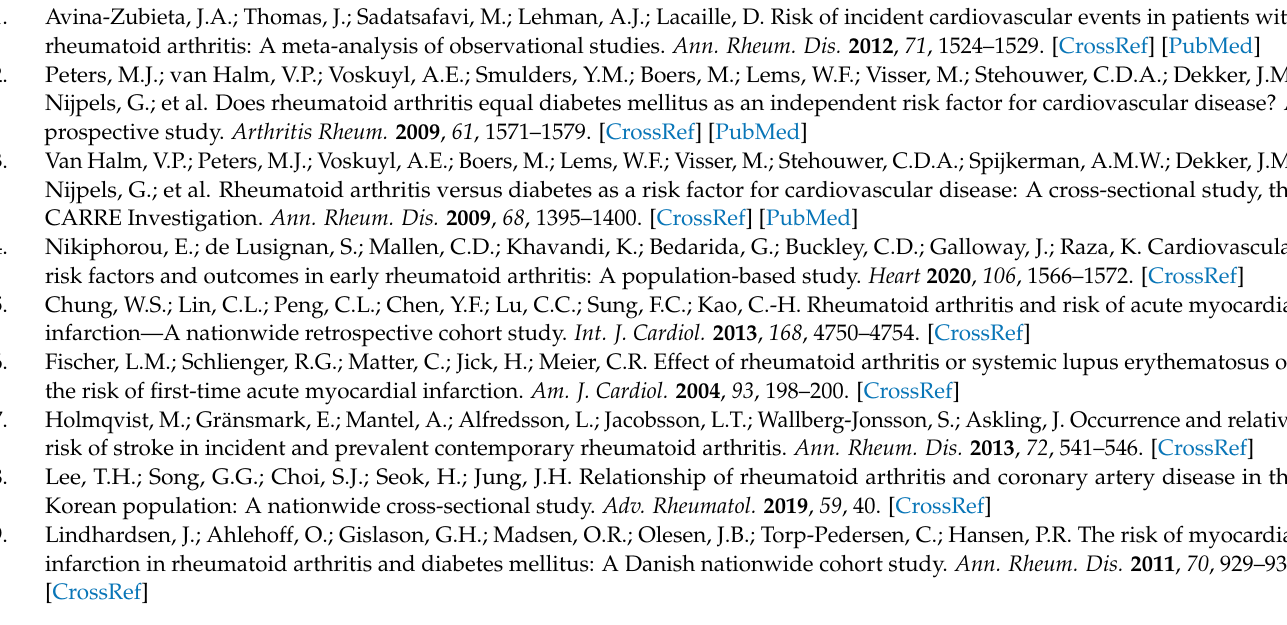
Table S2. Stratified analysis–Stroke; Table S3. Baseline characteristics of the study population before and after PSM; Table S4. Association between CV event and RA in the PSM